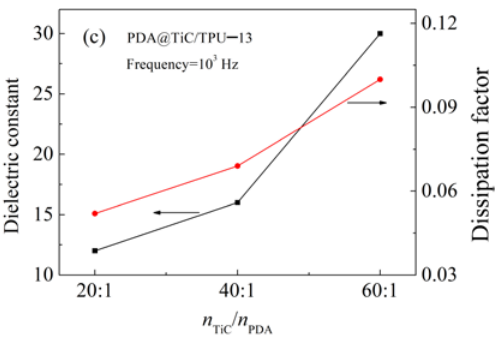
Figure 7. Frequency dependence on the dielectric constant ( a ), dissipation factors ( b ) of TPU and TPU composites with different mole ratio of titanium carbide to dopamine. Dielectric constant and dissipation factors of TPU composites with a different mole ratio of titanium carbide to dopamine at 10 3 Hz and room temperature ( c ).